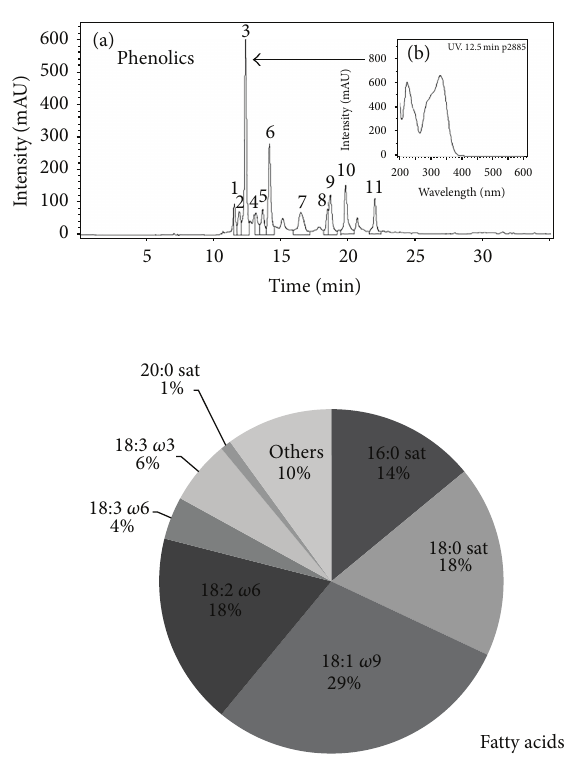
Figure 5: Chromatographic analysis of the infusive Lantana grise- bachii extract: phenolics with a 0.723 mg/g chlorogenic ( arrow ) and fatty acids (%; others-each one < 1%—: 14: 0, 14: 1 𝜔 9, 16:1 𝜔 7, 20 :1 𝜔 9, 20 :3 𝜔 3, 20 :4 𝜔 6, 22: 1 𝜔 9, 22 : 5 𝜔 3, 24 : 0, and 24: 1 𝜔 9) ( ∗ 𝑃 < 0.05